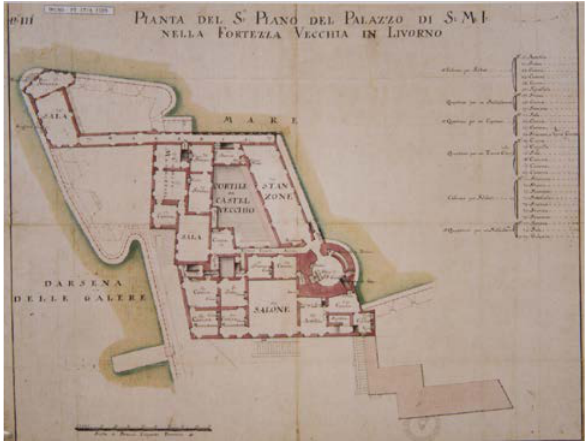
Figure 3: “ Pianta del S.o del Palazzo di S.M.I. nella Fortezza Vecchia in Livorno ”, XVIII century (cart. XVII A, n.